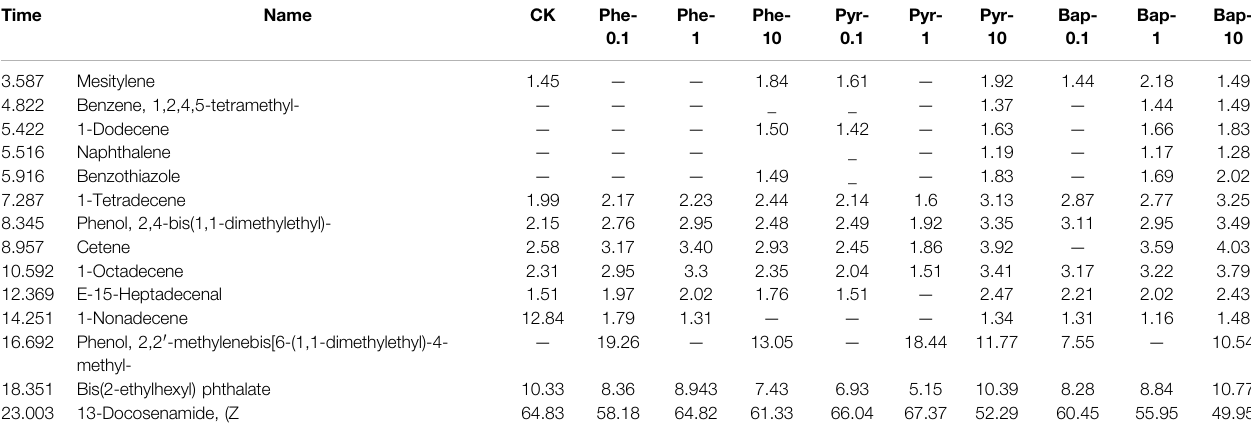
TABLE 2 | GC-MS measurement results of composition and relative content of root exudates after 30 days PAHs hydroponic stress. Time Name